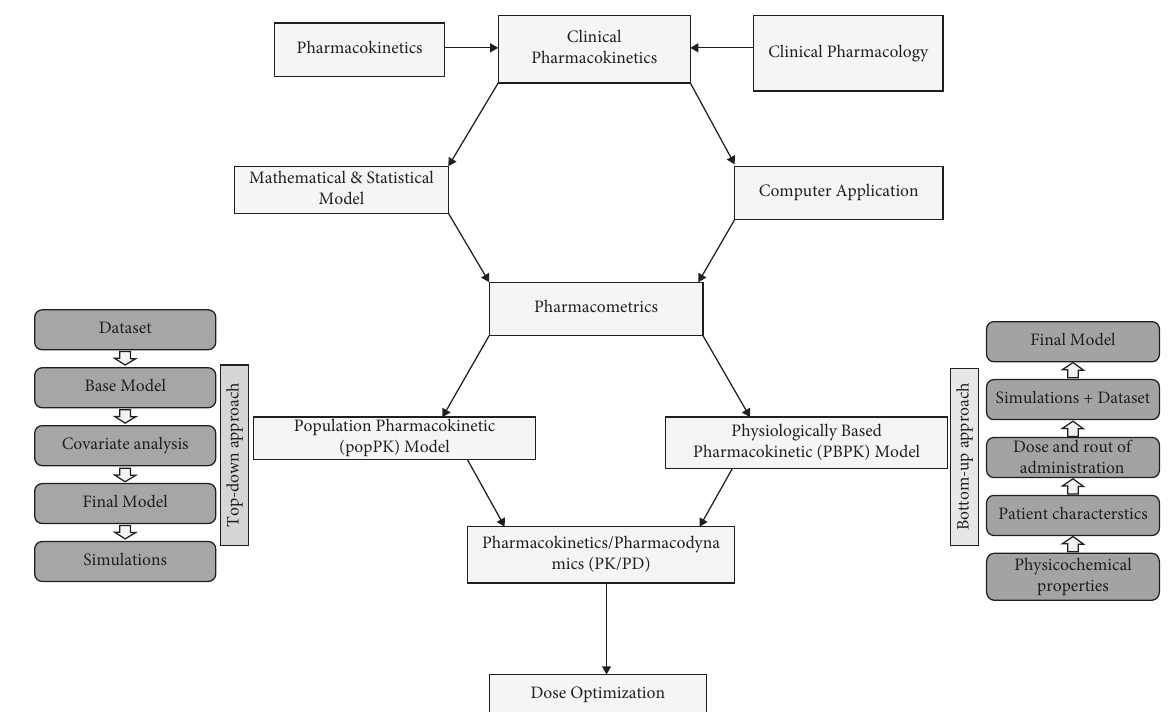
Figure 1: Te schematic diagram showing the components of